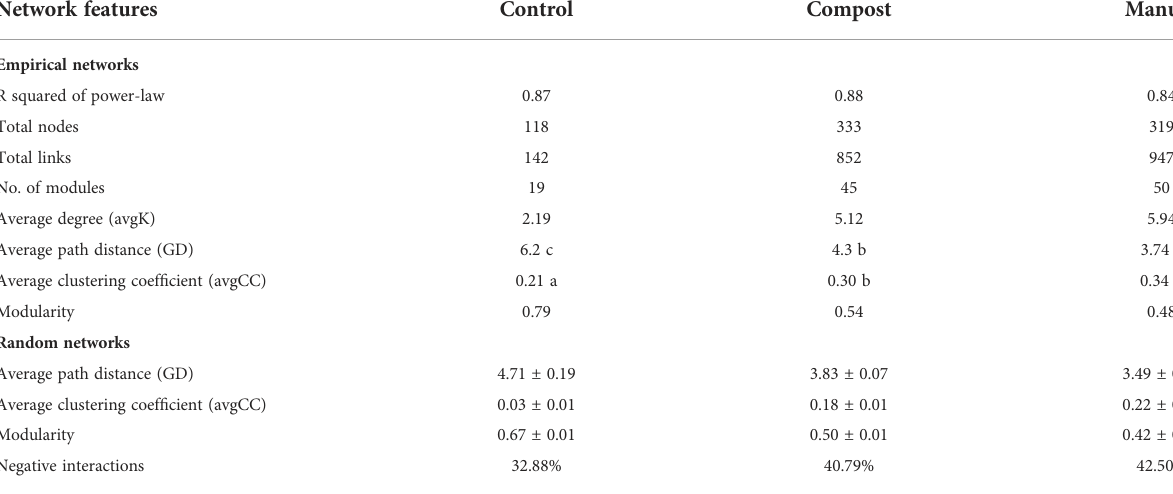
TABLE 1 Topological features of empirical networks and random networks for combined bacterial and fungal communities. Network